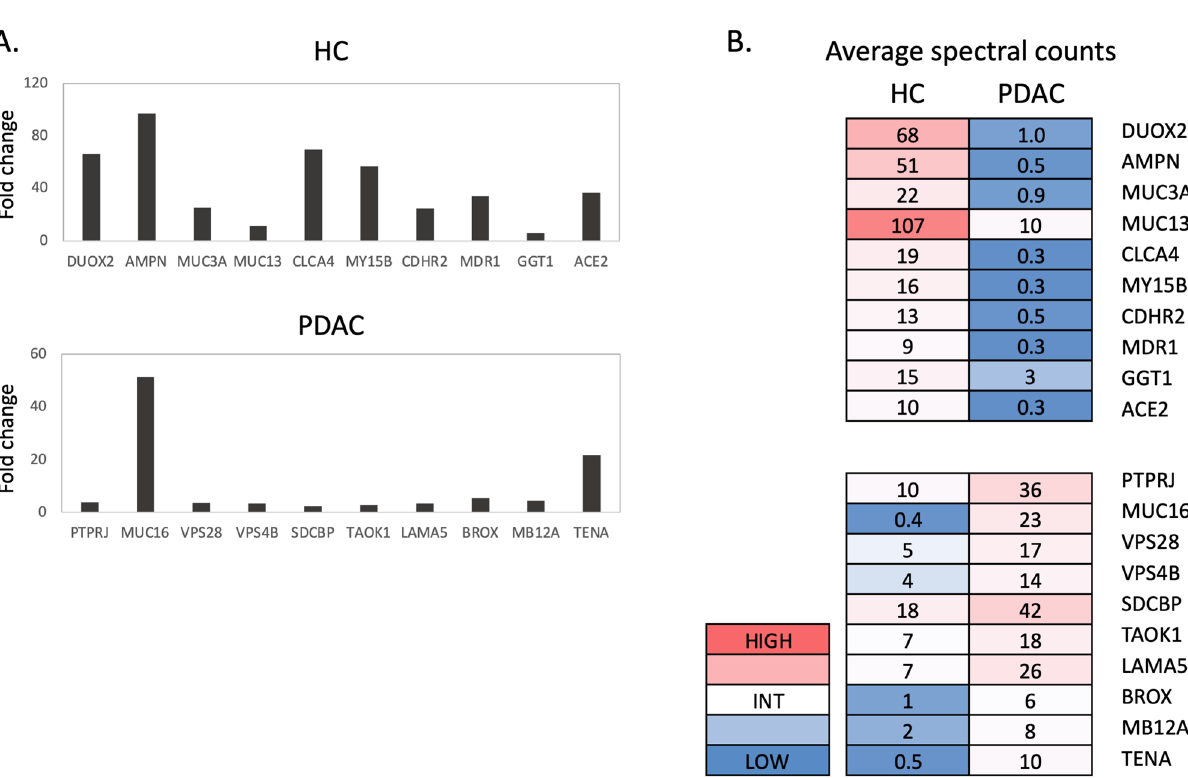
Figure 4. Proteomic analysis of EV samples isolated from four healthy control (HC) and four pancreatic cancer (PDAC) organoid cultures (4 × 4 study). ( A ) Fold change of spectral count averages for top 10 proteins upregulated in HC (top panel) and top 10 proteins upregulated in PDAC (bottom panel). ( B ) Spectral count averages in the HC or PDAC group for each corresponding protein identified in ( A